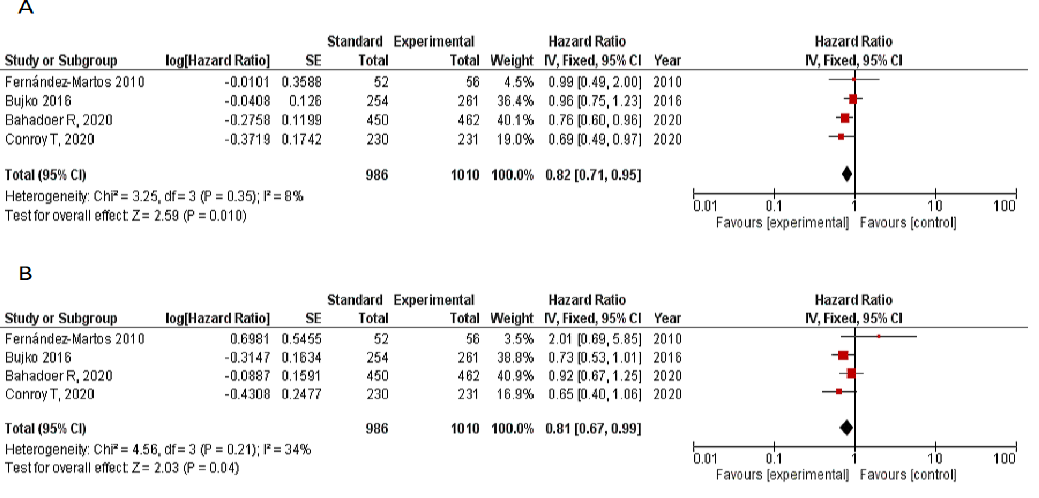
Figure 3. ( A ) Forest plot for 3-year DFS TNT vs. CRT. ( B ) Forest plot for 3-year OS TNT vs. CRT.